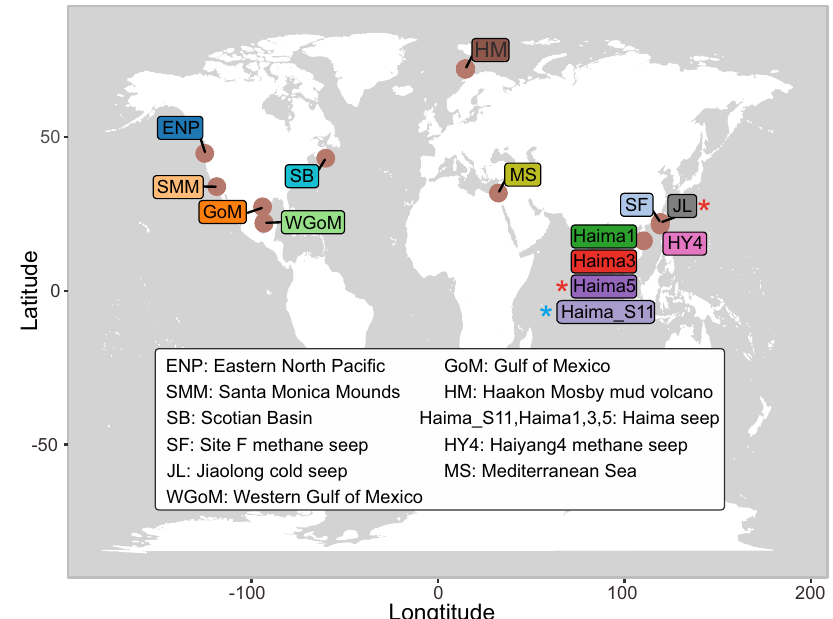
Fig. 1 | Geographic distribution of 11 cold seep sites where metagenomic and metatranscriptomic data were collected. These samples were originated from fi vetypesofcoldseeps:gashydrates,mudvolcanoes,asphaltvolcanoes,oilandgas seeps and methane seeps. Sites with red asterisks denote that both metagenomes